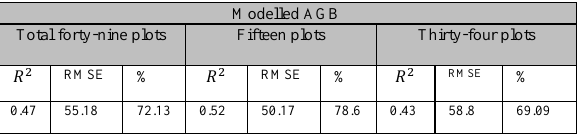
Table 5: -RMSE and Accuracy (%) obtained for modelled AGB Modelled AGB Total forty-nine plots Fifteen plots Thirty-four plots